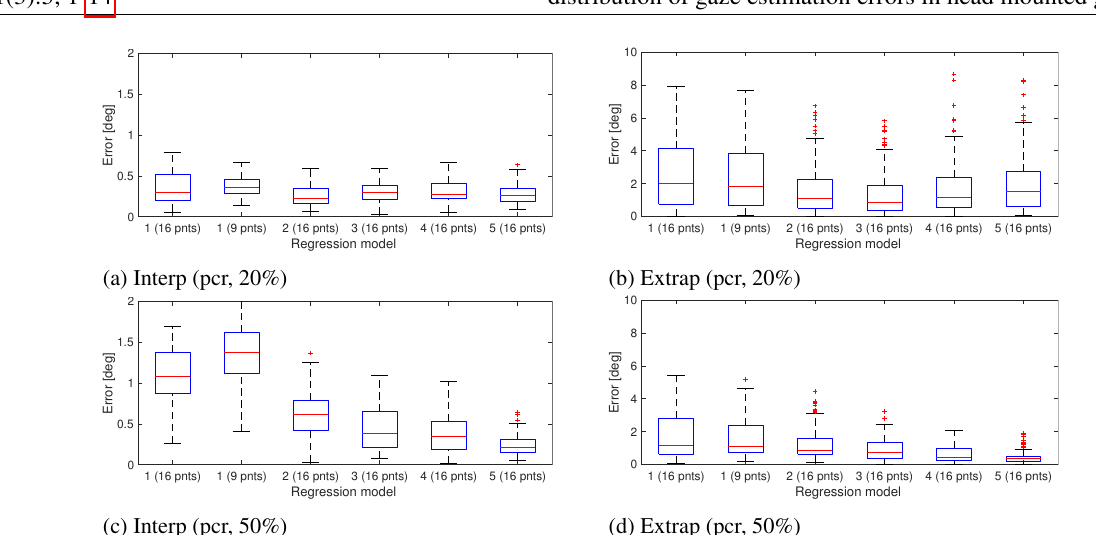
Figure 8 . Gaze estimation error obtained from di ff erent regression models for interpolation and extrapolation regions of the scene image. Gaze estimation was based on the PCR feature and no measurement noise was applied to the eye image. Errors are measured in degrees.